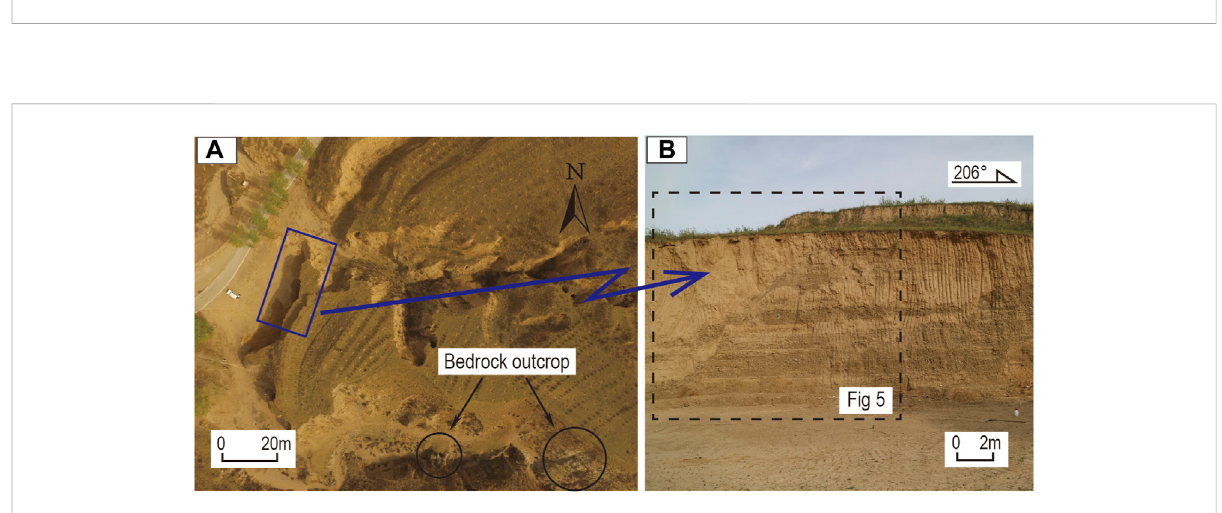
FIGURE 4 (A) Top view shows Site 1 near Xujiabao village. See Figure 1 for the location. (B) Field photograph of the fault